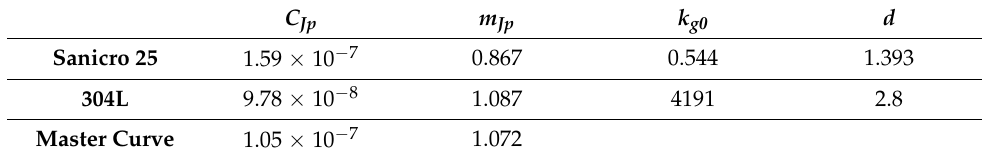
Table 5. Material parameters for both Hutaˇr and Pol á k